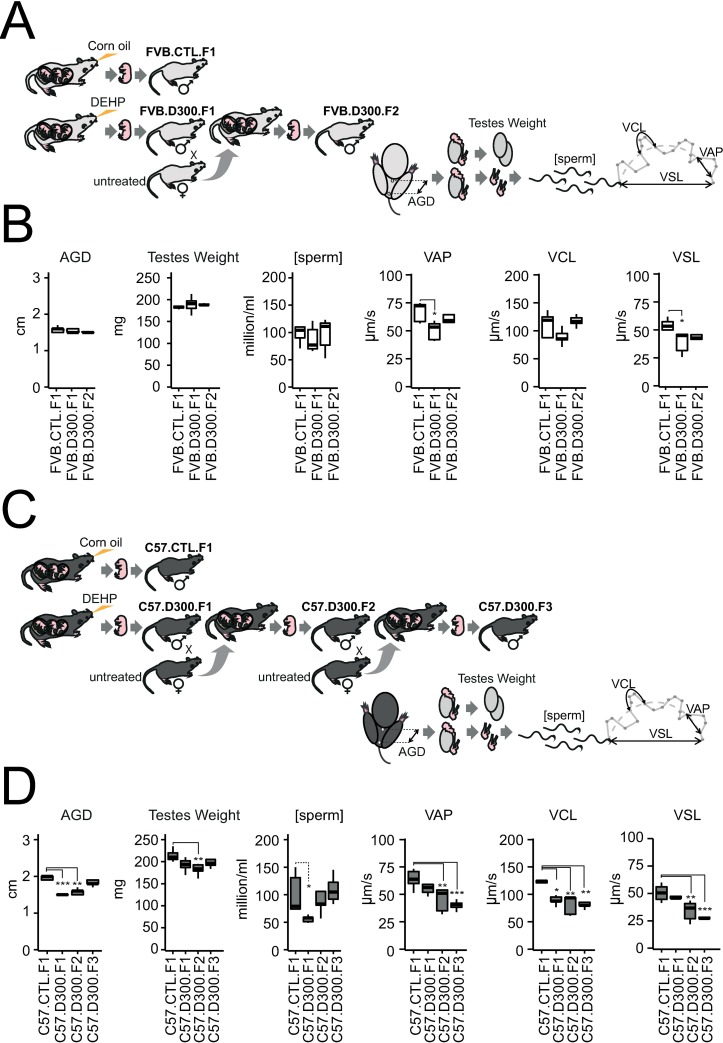
Strain-dependent alterations of fertility parameters in male offspring exposed in utero to DEHP.Prenatal exposures to DEHP were performed daily from E9-19 in both FVB/N and C57BL/6J mice strains using per os injections in hand-restrained pregnant females. Injections of 20 μl of 1.15 M DEHP diluted in corn oil corresponding to 300 mg/kg/day (D300) for 30 g mice estimates were compared with injections of 20 μl of corn oil as a vehicle for a fat-soluble compound, settled as the control condition (CTL). Male fertility parameters were obtained at P100 using five biological replicates per condition. AGD and testes weight were obtained prior to computer-assisted sperm analysis (CASA). CASA was used to assess sperm concentrations expressed in million per ml [sperm] and sperm velocities expressed in μm per second (μm/s). VAP: average path velocity; VCL: curvilinear velocity; VSL: straight-line velocity. (A) Experimental design of the study performed in the strain FVB/N. FVB.CTL.F1 were born from the corn oil-exposed mother. FVB.D300.F1 males were born from the DEHP-exposed mother. FVB.D300.F2 males were obtained after mating with unexposed females with FVB.D300.F1. (B). Male fertility parameters obtained in FVB after prenatal exposure to DEHP. AGD, testes weight, sperm concentrations and VCL did not differ across the tested conditions. VAP (p-value <0.02) and VSL (p <0.02) were decreased in FVB.D300.F1 compared with FVB.CTL.F1. (C). Experimental design of the study performed in the strain C57BL/6J. C57.CTL.F1 males were born from the corn oil-exposed mother, whereas C57.D300.F1 males were born from the DEHP-exposed mother. C57.D300.F2 males were obtained after mating with an unexposed female with C57.D300.F1. C57.D300.F3 males were obtained after mating with an unexposed female with C57.D300.F2 males. (D) Male fertility parameters obtained in C57BL/6J strain after prenatal exposure to DEHP. Compared with C57.CTL.F1, AGD, sperm concentration and VCL were decreased in C57.D300.F1 (p <7*10−5, p <0.05, p <0.02, respectively), AGD (p < 0.002), testes weight (p <0.008), VAP (p <0.008), VSL (p <0.008) and VCL (p <0.003) were decreased in C57.D300.F2, and VAP (p <1*10−3), VSL (p <1*10−3) and VSL (p <0.004) were decreased in C57.D300.F3. Statistical significance was performed using a one-way analysis of variance with a post-hoc Tukey honestly significant difference test (ANOVA-Tukey HSD). Significant differences between the tested conditions and the control conditions are reported as a graphic. * corrected p-value <0.05, ** corrected p-value <0.01, *** corrected p-values <0.001. Shapiro-Wilk tests reveal that the following parameters most likely followed a normal distribution; weight of the testes (W = 0.98, p = 0.62), sperm concentration (W = 0.98, p = 0.68), VAP (W = 0.97, p = 0.39), VCL (W = 0.96, p = 0.17) and VSL (W = 0.96, p = 0.17), whereas AGD (W = 0.83, p = 0.0001) did not follows a normal distribution. The Bartlett’s test for homogeneity of variances reveal equal variance between groups for all parameters; weight of the testes (Bartlett's K-squared = 9.13, df = 6, p = 0.17), AGD (Bartlett's K-squared = 9.18, df = 6, p = 0.16), VAP (Bartlett's K-squared = 4.26, df = 6, p = 0.64); VCL (Bartlett's K-squared = 6, df = 6, p = 0.42), VSL (Bartlett's K-squared = 5.73, df = 6, p = 0.45) and the sperm concentration (Bartlett's K-squared = 12.58, df = 6, p = 0.05). Caution has to be taken in the interpretation of statistical differences in AGD across the tested conditions in the present work due to non-normal distribution of the data.